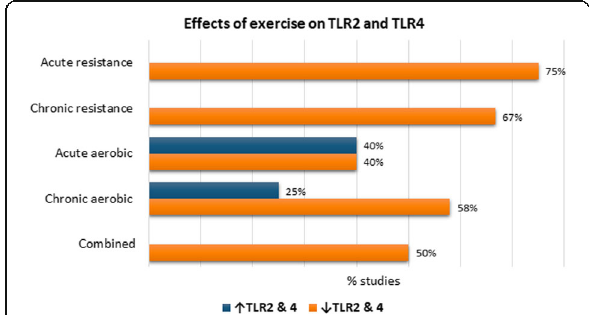
Fig. 3 Effects of exercise on TLR2 and TLR4. For chronic resistance exercise, 67% of studies reported a reduction of TLR4 and/or TLR2 expression. For acute resistance exercise, 75% of studies revealed a decrease in the expression of these receptors. For chronic aerobic exercise, 58% of studies reported a reduction in TLR4 and/or TLR2 expression and 25% found an increase in the expression of TLR4 and/or TLR2. For acute aerobic exercise, 40% of studies showed a decrease and 40% reported an increase. Regarding combined exercise, 50% of studies reported a reduction in the expression of the receptors